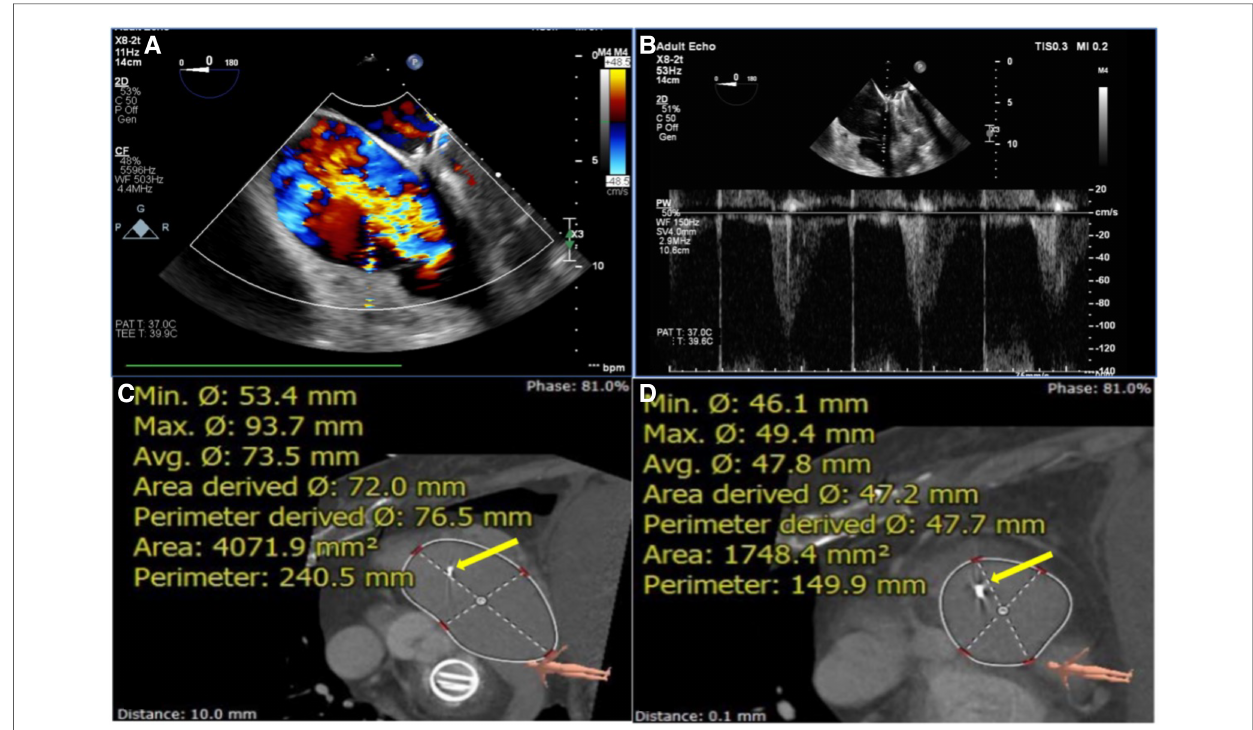
FIGURE 1 Assessment of TEE and CTA before TTVR evaluated the status of TV (e.g., data for patient #6) assessment of RA and RV using circle cardiovascular imaging CVI42 software. ( A ) TEE showed large regurgitation on TV. ( B ) The maximum velocity of TV was up to 1.1 m/s. ( C, D ) The area of the RA was 4071.9 mm 2 , and the area of the RV was 1748.4 mm 2 . The yellow arrows indicate the lead of the permanent pacemaker. TEE, transesophageal echocardiography; CTA, computed tomography angiography; TTVR, transcatheter tricuspid valve replacement; TV, tricuspid valve; RA, right atrium; RV, right ventricle; TA, tricuspid